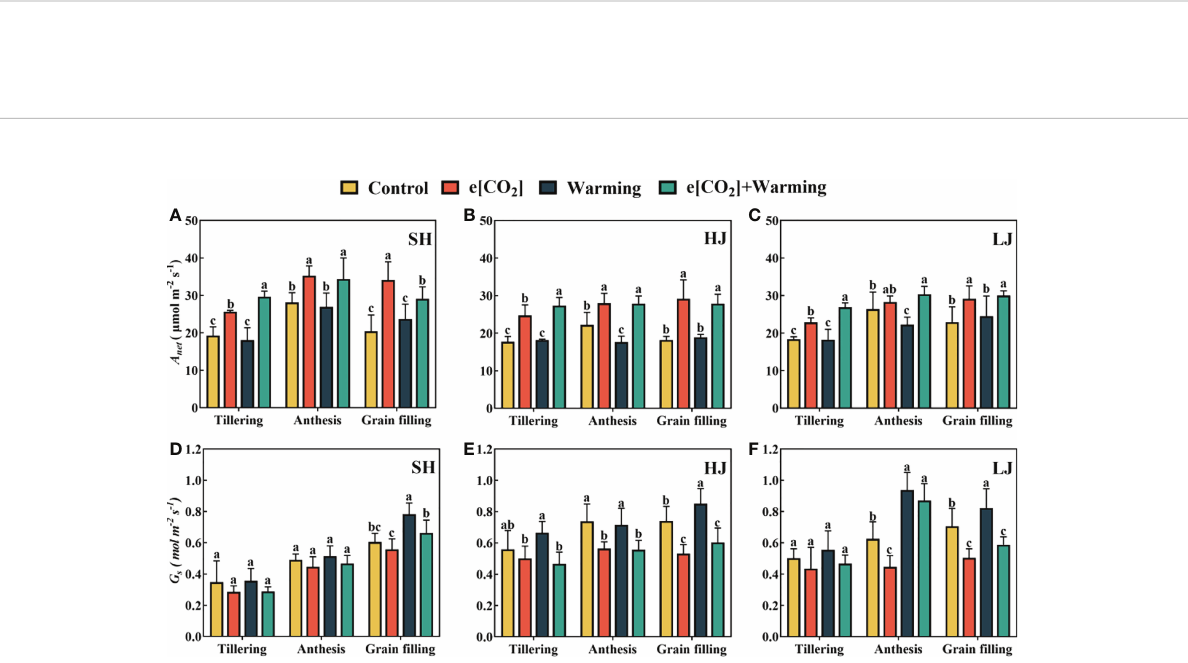
FIGURE 2 The responses of A n (A – C) and G s (D – F) measured under control, ambient condition; e[CO 2 ], eCO 2 concentration; warming, elevated air temperature; e[CO 2 ] plus warming, the combination of elevated air temperature and [CO 2 ] during the stages of tillering, anthesis and grain fi lling. SH, HJ and LJ refer to three rice cultivars Shishoubaimao, Hejiang 19, and Longjing 31, respectively. Values are the means ± SEs (n = 6). Different lower-case letters indicate signi fi cant differences between treatments at P < 0.05 level. A n , net photosynthetic rate; G s , stomatal conductance.